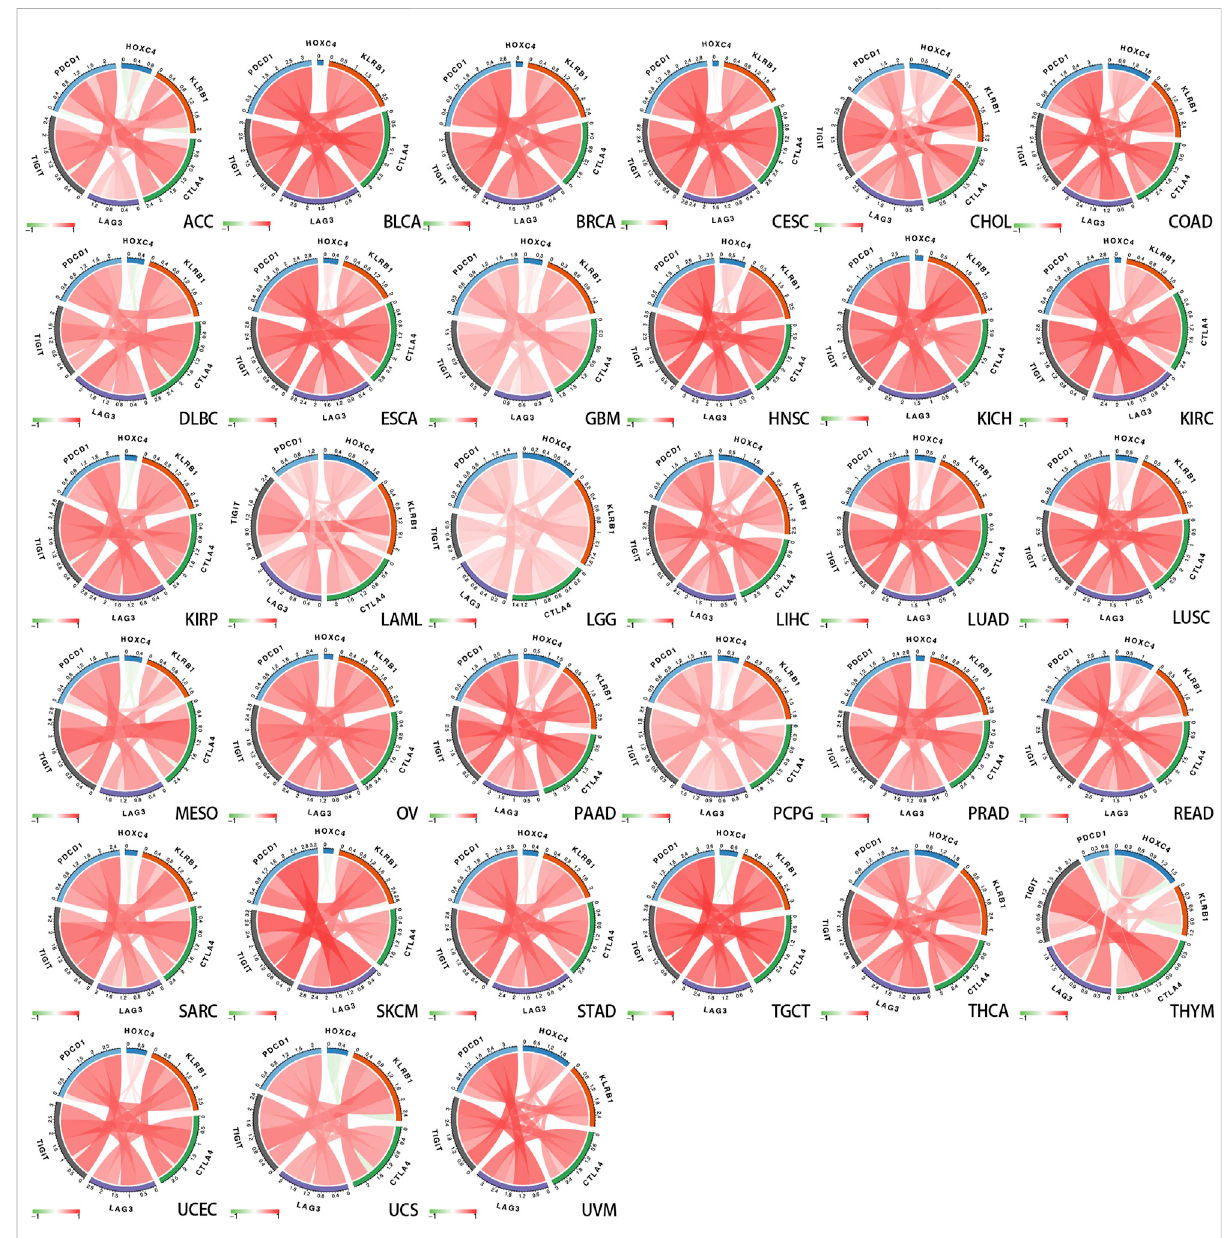
FIGURE 6 Correlation between HOXC4 expression and fi ve main immune checkpoint genes from TCGA